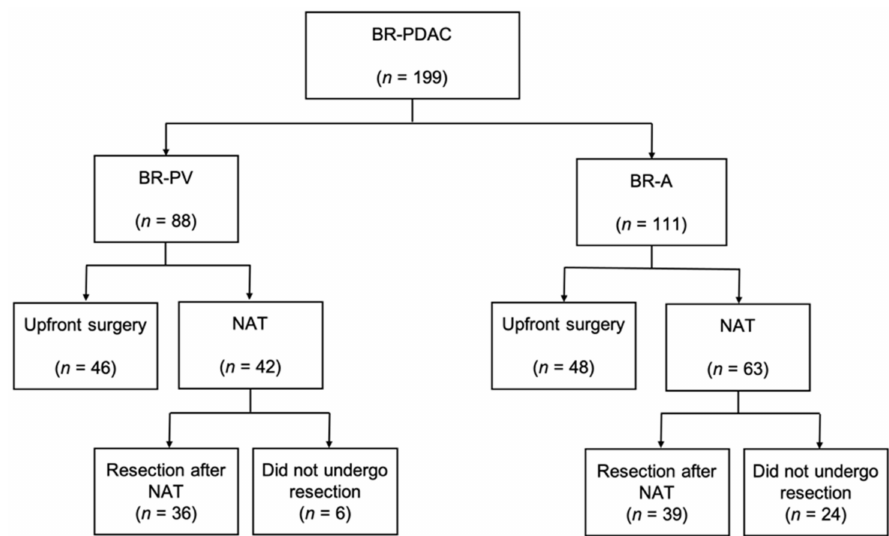
Figure 1. Study profiles and clinical courses of the enrolled patients. BR, borderline resectable; PDAC, pancreatic ductal adenocarcinoma; NAT, neoadjuvant